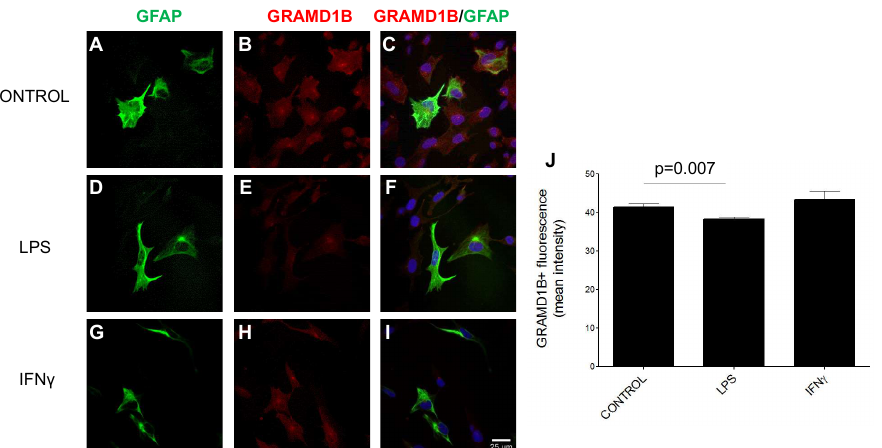
Figure 7. GRAMD1B expression in culture of human astrocytes before and after stimulation with inflammatory stimuli. ( A – I ) Immunohistochemistry of GRAMD1B expression in control conditions ( A – C ) and after LPS ( D – F ) and IFNγ ( G – I ) stimulation. ( J ) Histogram of GRAMD1B quantification